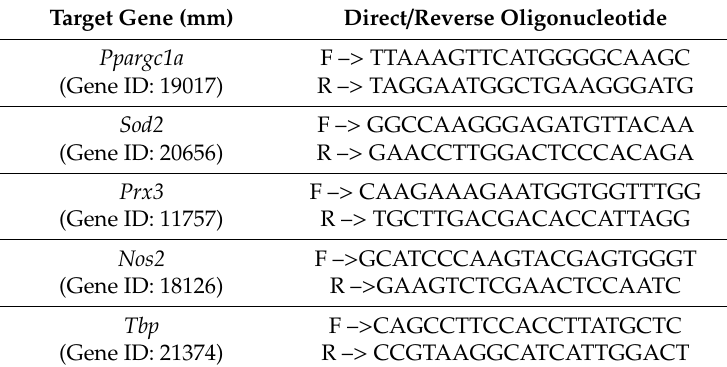
Table 1. The oligonucleotides used for RT-qPCR.